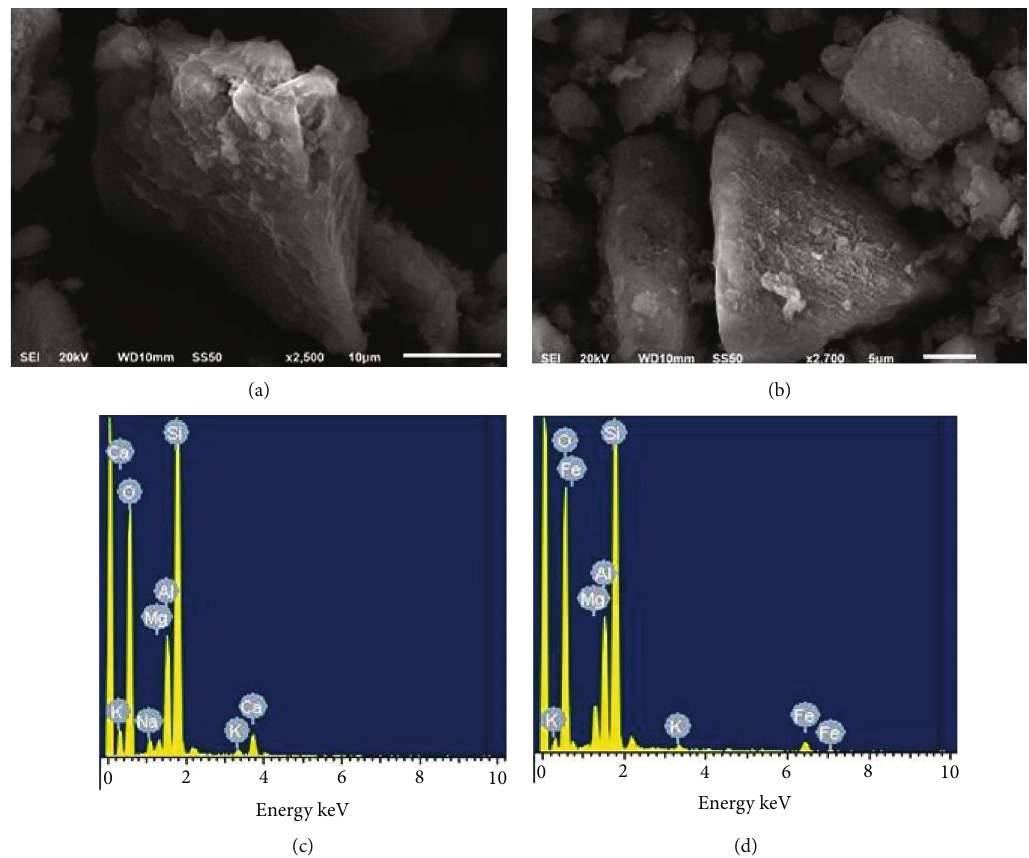
Figure 2: (a, b) SEM micrographs and (c, d) SEM/EDX elemental microanalysis for CH-N and CH-MS